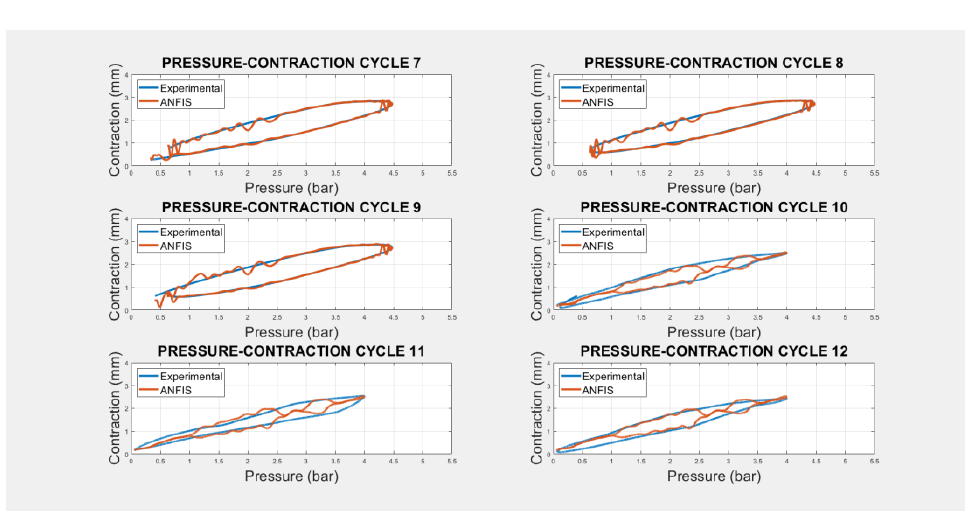
Figure 11. A portion of the generalized model that compares experimental data against the ANFIS model at two different input voltage amplitude–frequency